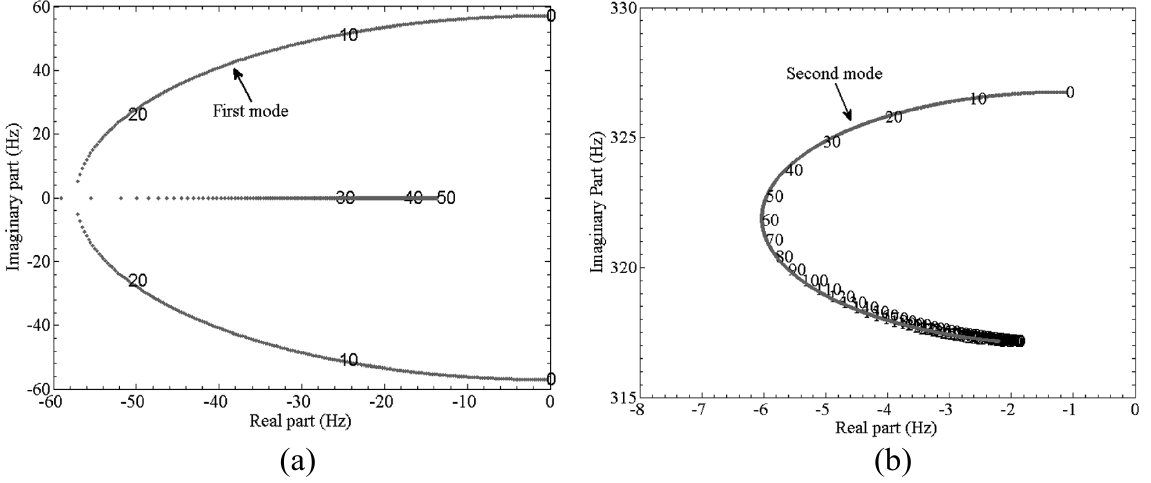
Fig. 8. Root locus diagram for the (a) fi rst and (b) second modes obtained by varying the control